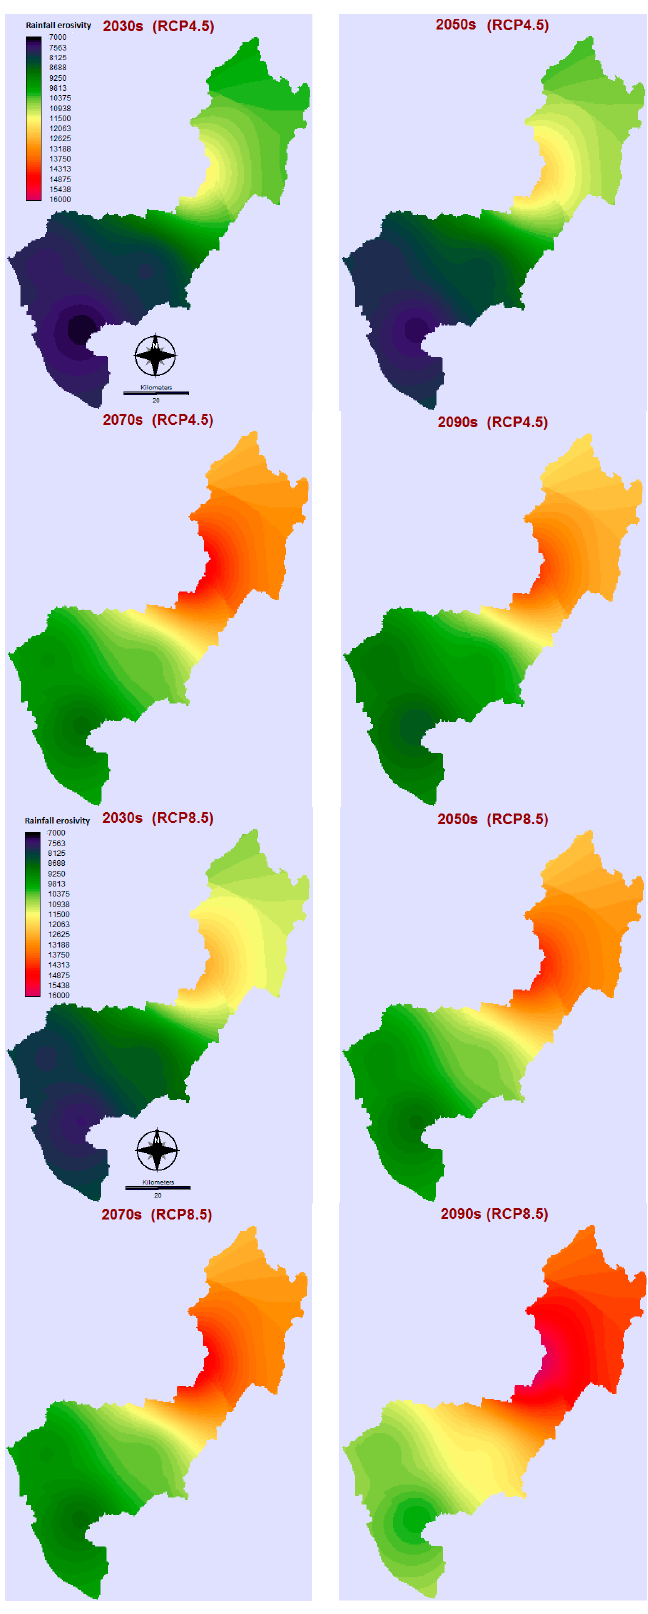
Figure 9. Rainfall erosivity maps using multivariate models under RCP4.5 (MJ mm ha − 1 h − 1 year − 1 ).